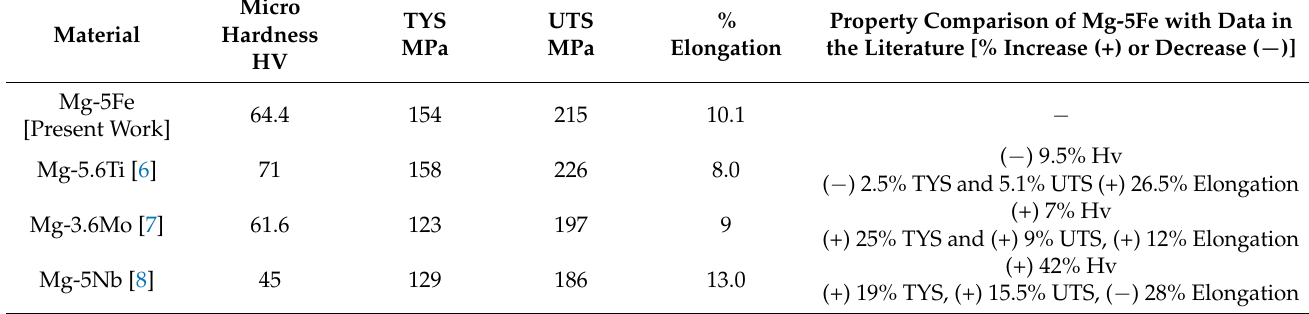
Table 7. Compression properties of Mg-5Fe and Mg composites having other metallic reinforcements [6,8]. Material